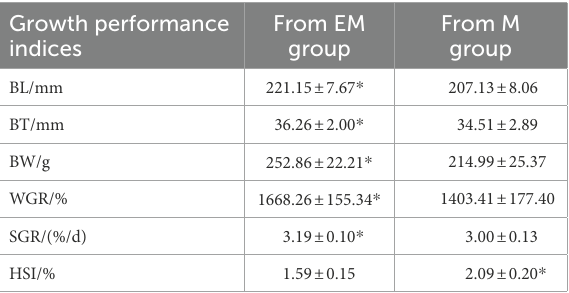
TABLE 1 Growth performance indices of largemouth